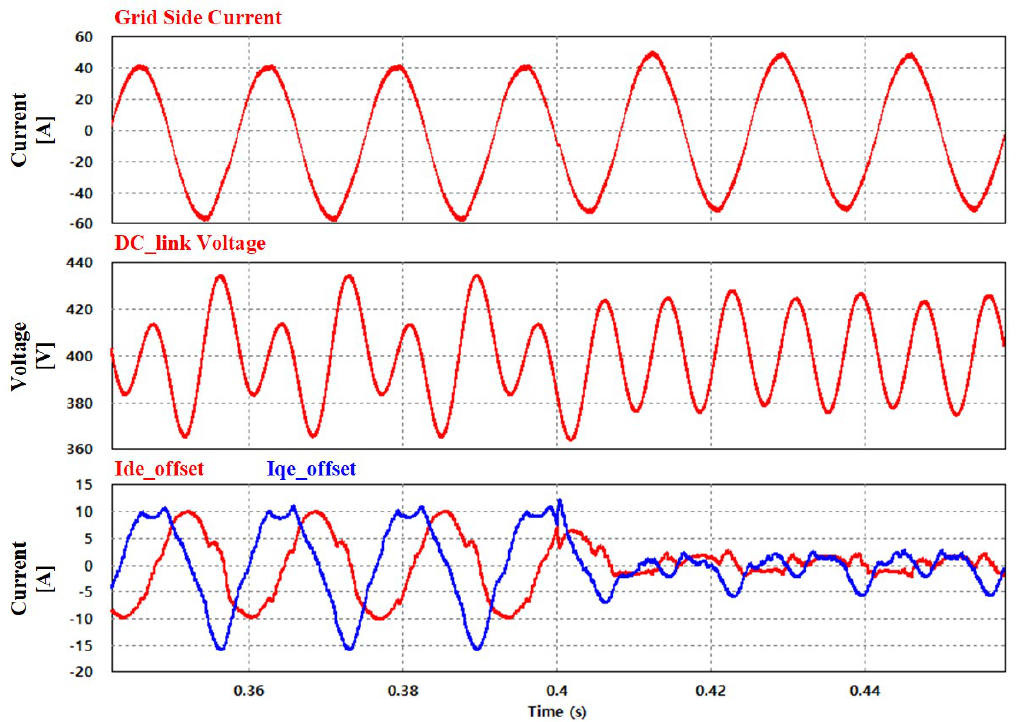
Figure 9. Simulation results of DC offset compensation method.